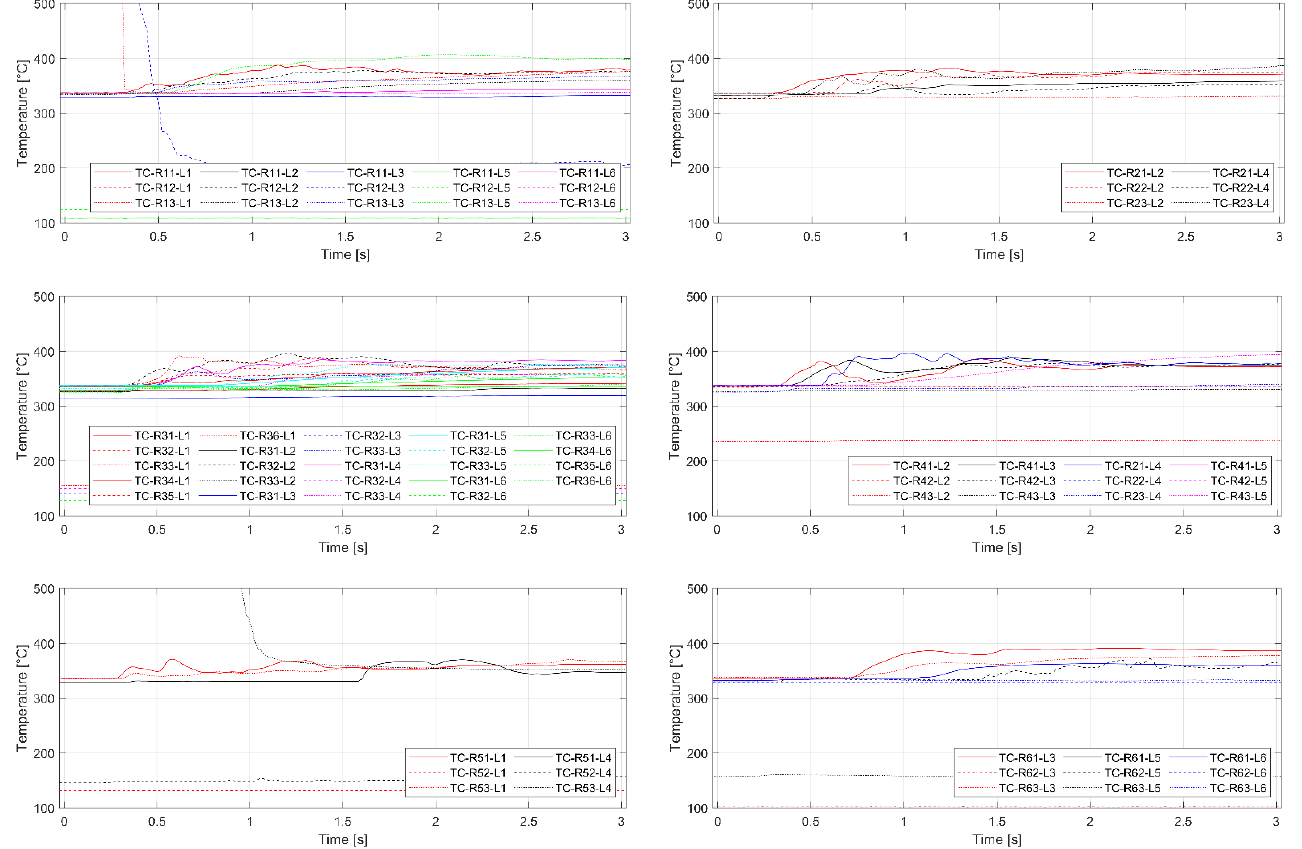
Figure 12. T emperature time trends in S1B at different rings (from Ring 1 to Ring 6, see Figure 3b).